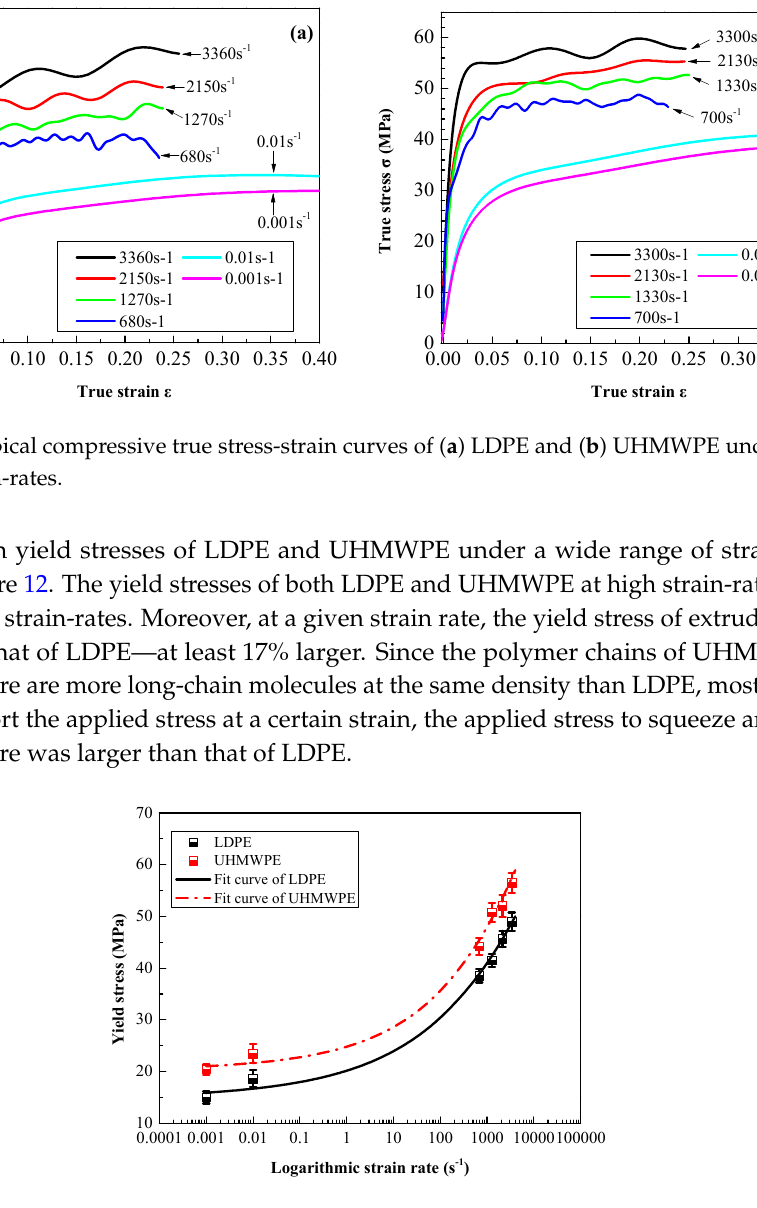
Figure 12. Yield stress of LDPE and UHMWPE under wide range of strain rates (from 0.001 to 3300 s − 1 ).